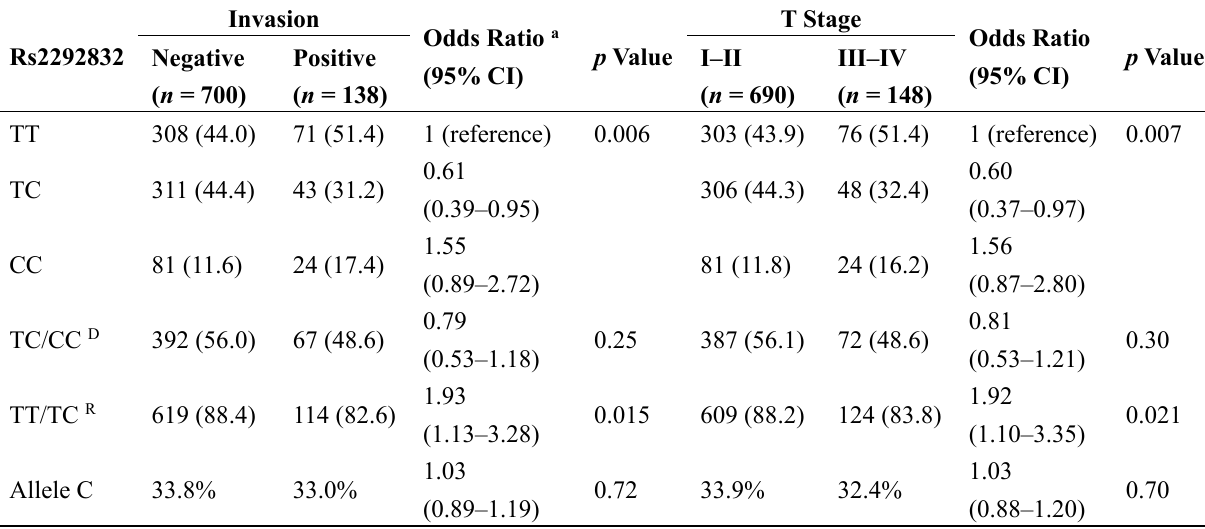
Table 4. Multivariate regression analysis for rs2292832 single nucleotide polymorphism (SNP) and local progression features of